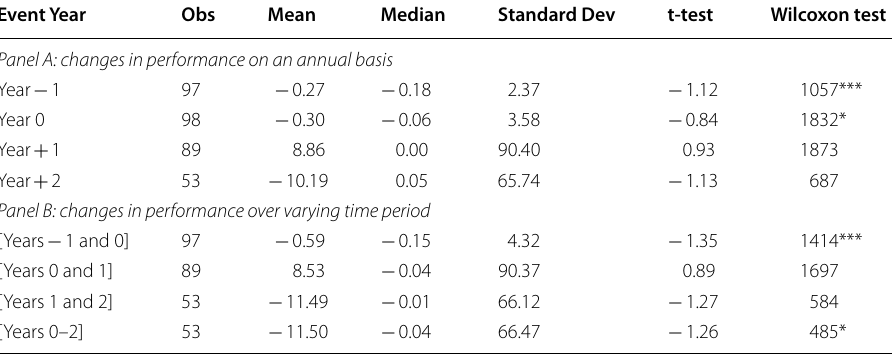
Table 9 Control adjusted percentage changes in operating